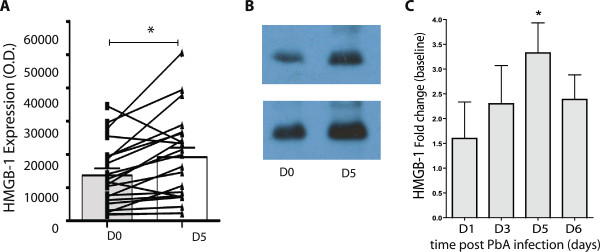
HMGB1 is elevated in plasma of mice susceptible to developing severe and fatal malaria following Plasmodium berghei ANKA infection. Plasma expression levels of HMGB1 were measured by Western blot from plasma collected on day 5 post-infection with Plasmodium berghei-ANKA, a rodent adapted parasite strain (A-B) Band intensities for D0 (grey bar) and D5 (white bar) in each group were compared on the same blot by using the NIH Image J software. Statistically significant differences between D0 and D5 were assessed by the paired t-test in each group. * indicates a p value of <0.05 (p = 0.004). Histograms represent mean + SEM obtained from a pooled result from at least two independent Western blot analyses from two independent PbA infection studies (n = 15-20/group). Representative Western blots are shown in panel (B). Systemic levels of HMGB1 in plasma over the course of PbA infection (on day 1, 3, 5 and 6 post infection) were assessed by ELISA in ECM-susceptible C57BL/6 mice (C). HMGB1 levels are shown as the fold change compared to the geometric mean of baseline HMGB1 levels obtained from naïve, uninfected littermate C57BL/6 mice. Bars represent mean + SEM (n = 5/time point). Statistical significant difference between day 1 and day 5 levels were determined by Kruskal Wallis with Dunn’s multiple comparison test. * indicates a p value of <0.05.